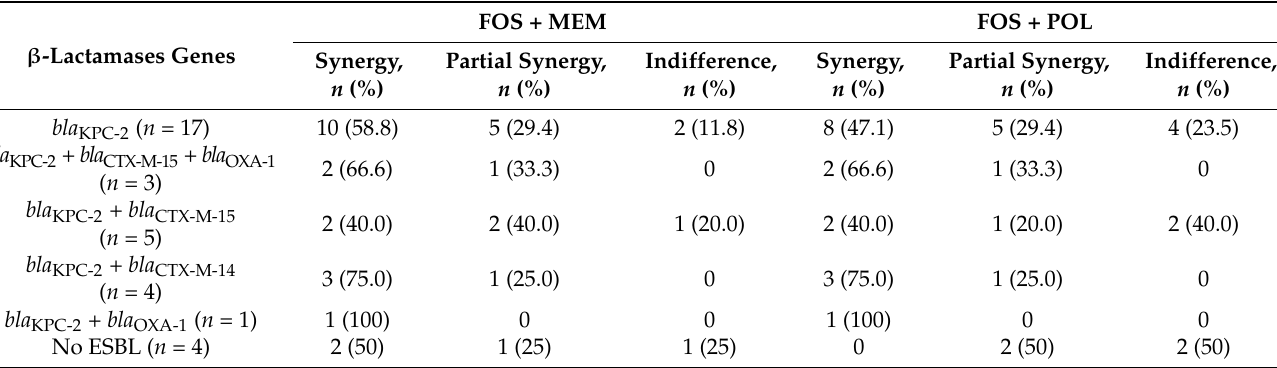
Table 2. CKA results split by β -lactamase content.